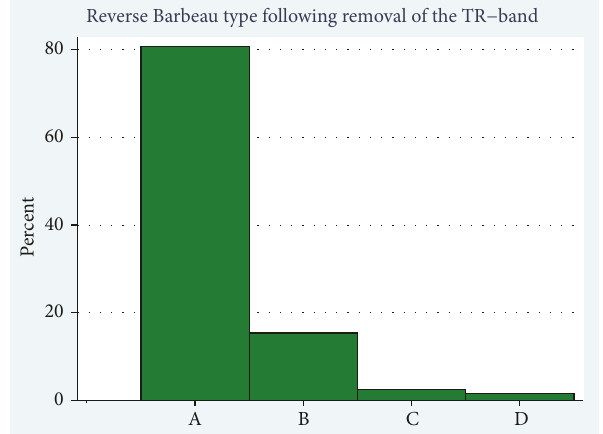
Figure 4: Results of Reverse Barbeau